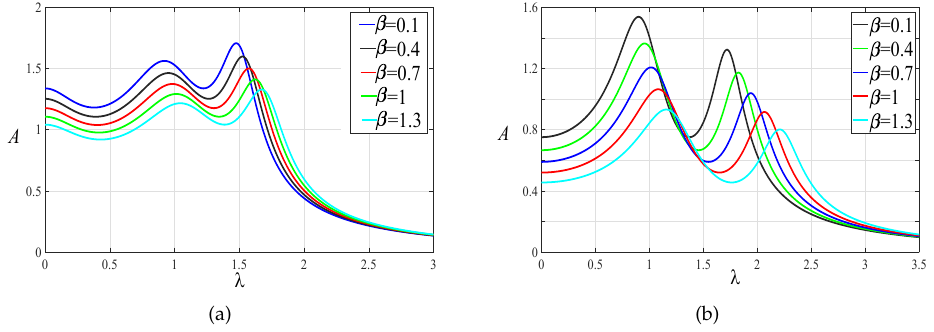
Figure 9. The effect of the inerter–mass ratio β on the response of the primary system: ( a ) α 1 > 0. ( b ) α 1 <